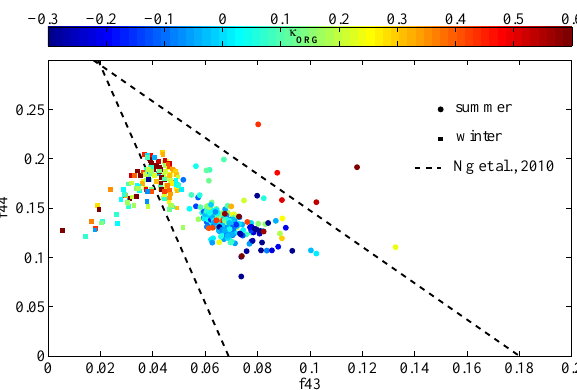
Fig. 11. Organic aerosol m/z 44 ratio to total organics (f44) as a function of m/z 43 ratio to total organics (f43). Tringle (dashed lines) are taken from Ng et al. (2010). Round symbols are used for summer and squared for winter. Data are averaged by 120-min for each point. The colour shows the calculated organic aerosol κ , based on AMS and CCNc